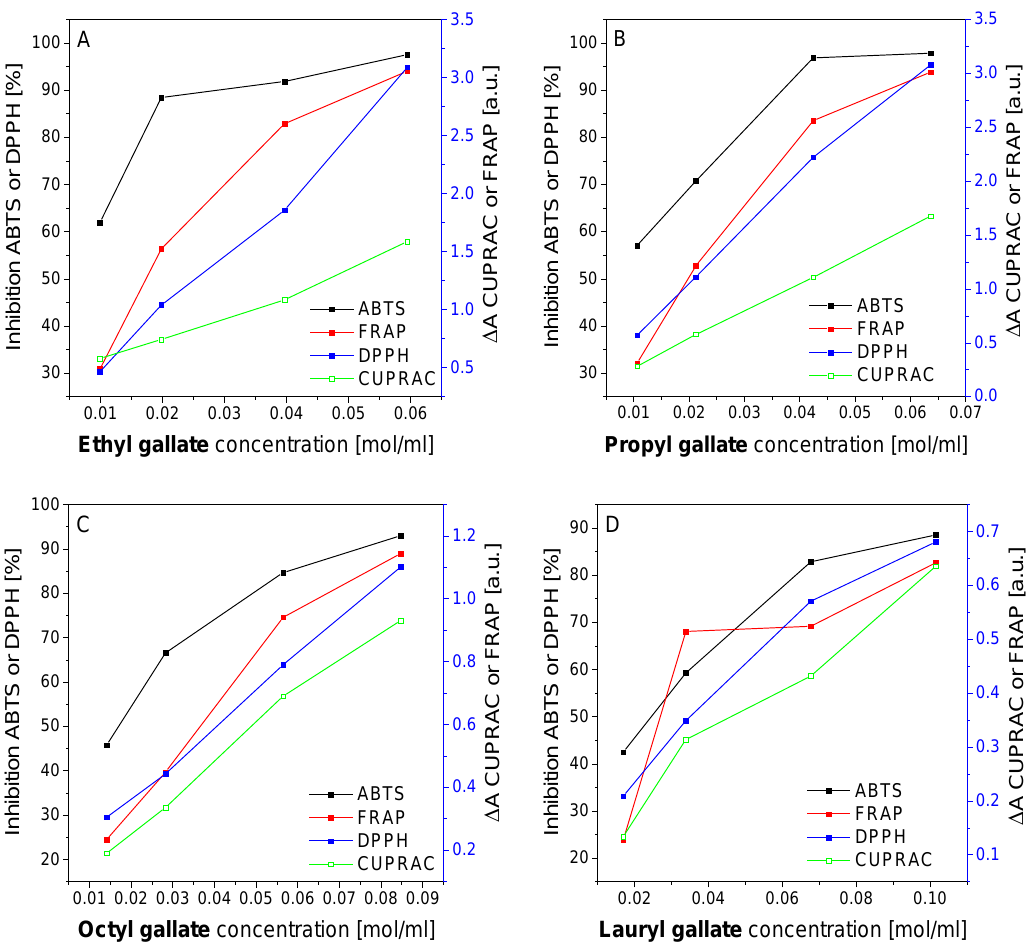
Figure 2. Antioxidant properties of ethyl gallate ( A ), propyl gallate ( B ), octyl gallate ( C ), and lauryl gallate ( D ) measured by the ABTS and DPPH methods and their ability to reduce iron (ferric reducing antioxidant power, FRAP) and cupric ions (CUPRAC).